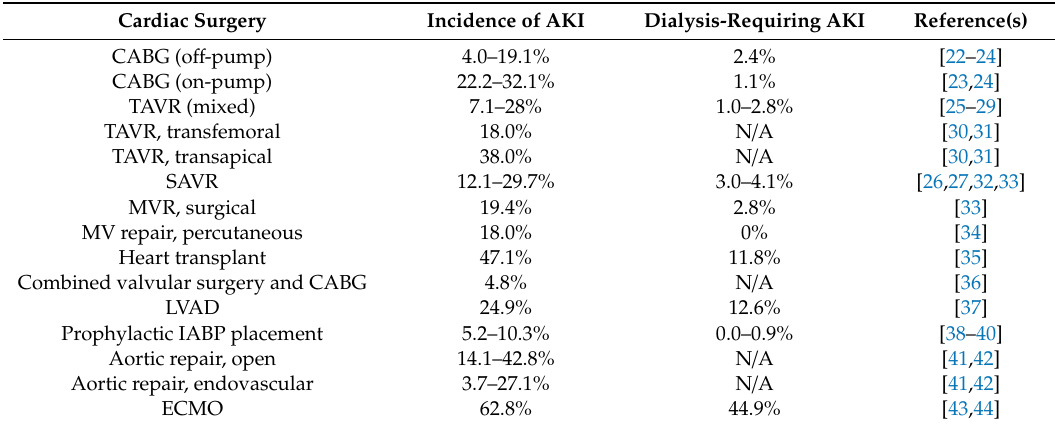
Table 1. Incidence of acute kidney injury following cardiac procedures and surgeries.